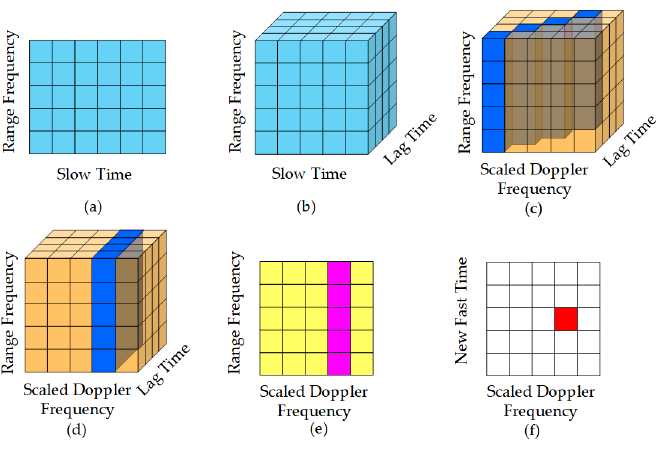
Figure 1. Target signal energy distributions by different processing stages: ( a ) target signal energy distribution in the range frequency domain; ( b ) target signal energy distribution in the subapertures; ( c ) target signal energy distribution after SFT operation; ( d ) target signal energy distribution after AR operation; ( e ) target signal energy distribution after phase compensation and complex addition operations; ( f ) target signal energy distribution after IFT operation.